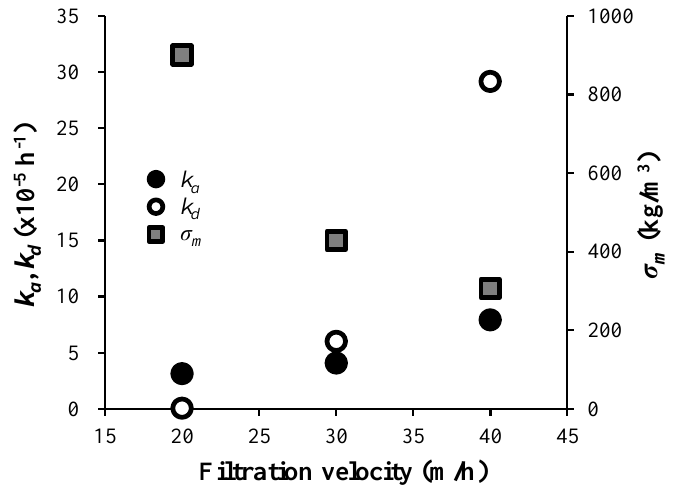
Figure 3. The variation in the kinetic model parameters with varying filtration velocity. Meanwhile, the values of k a and k d were 1.423–3.983 and 2.88 h − 1 , respectively, for the fibrous media with the fiber diameters of 1–26 um and with the porosity of 0.67–0.85